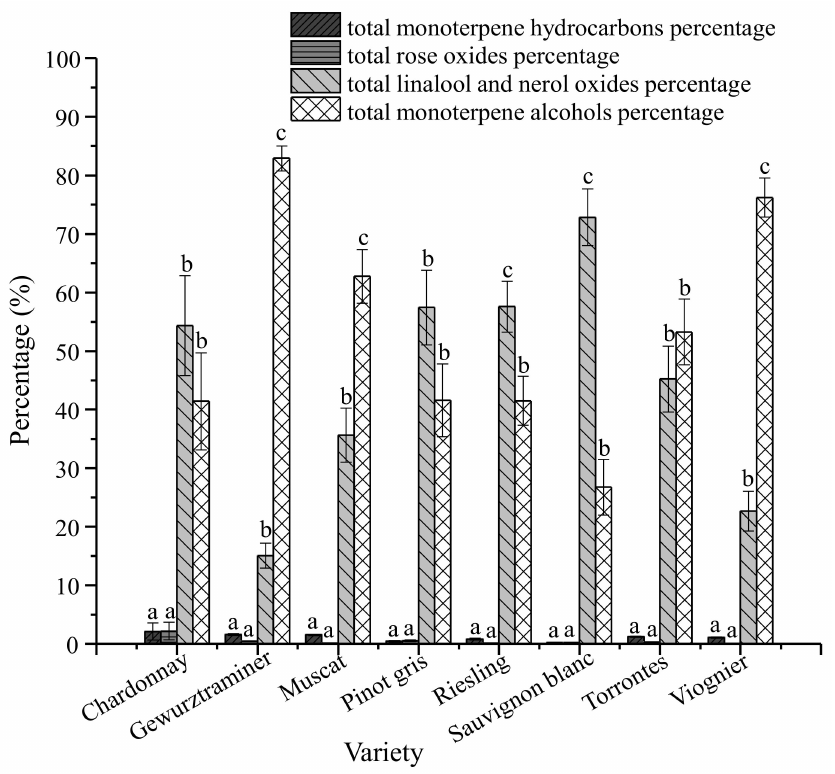
Figure 1. Clustered bar for isomers percentages in each varietal